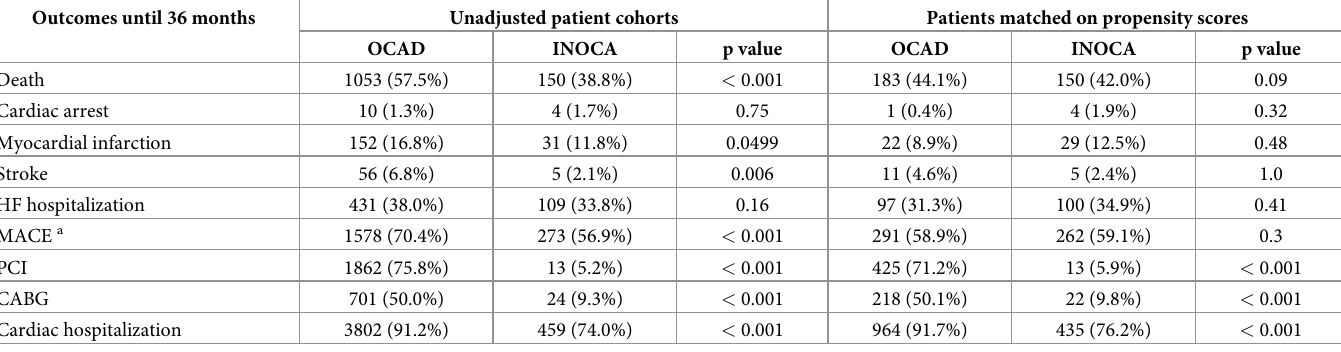
Table 3. Three-year outcomes of acute coronary syndrome patients with OAD and INOCA (unadjusted and after matching on propensity scores). Only patients with documented event or completed 36-month follow-up are